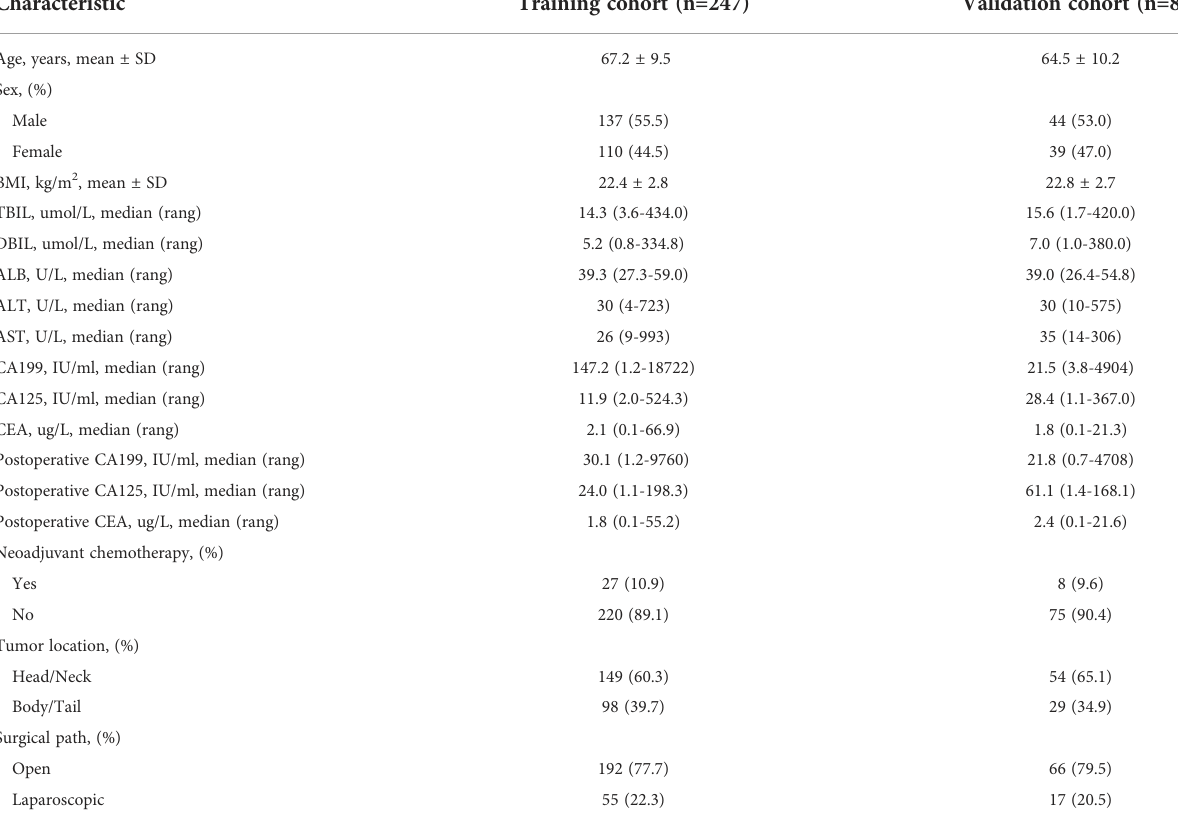
TABLE 1 Clinicopathological and treatment characteristics of PDAC patients in the training and validation cohorts.